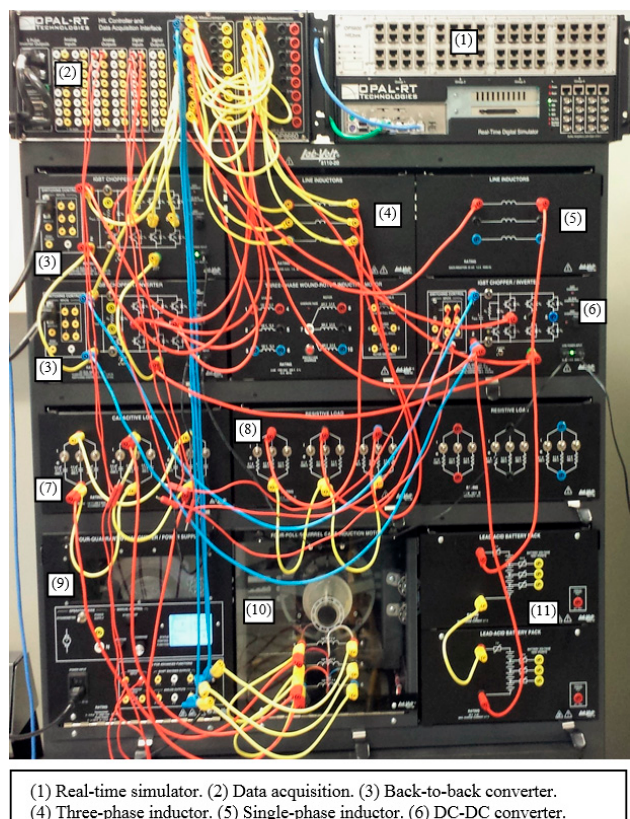
Figure 7. Experimental setup. Energies 2020 , 13 , x FOR PEER REVIEW